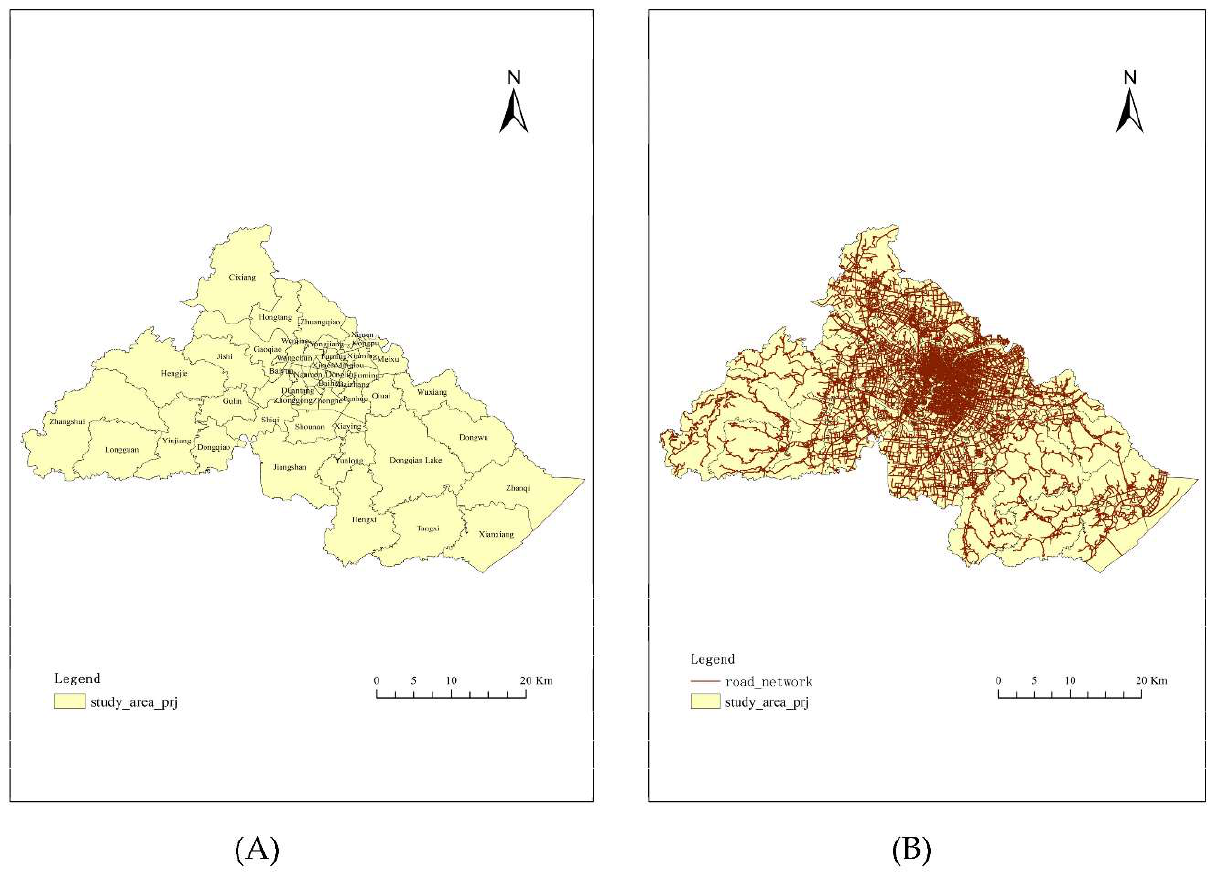
Figure 2. ( A )The administration boundary; ( B ) Road